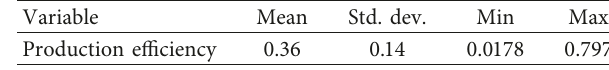
Table 3: Technical, allocative, and economic efficiency score. Variable